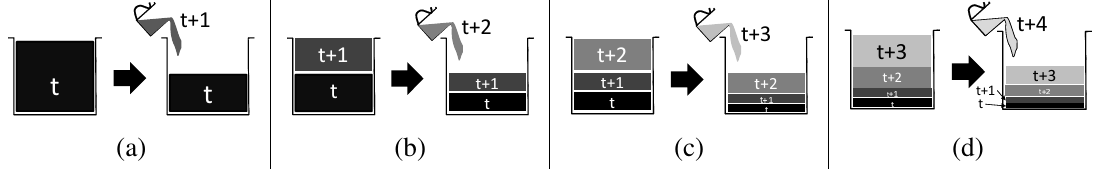
Figure 4. Evaporating pot model. ( a ) First pouring at t ; ( b ) pouring at t + 1 ; ( c ) pouring at t + 2 ; ( d ) pouring at t + 3